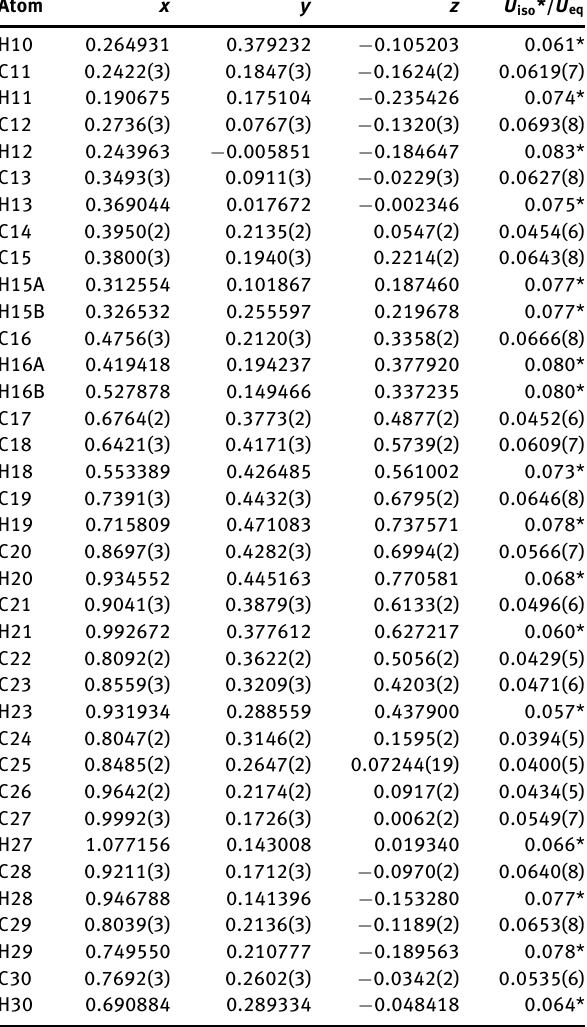
After the mixture was stirred for 20 min, the mixture was filtered off. The resulting filtrate was left undisturbed for about several days to form crystals suitable for X-ray crys- tallographic analysis. Yield: 57.2%. Elemental